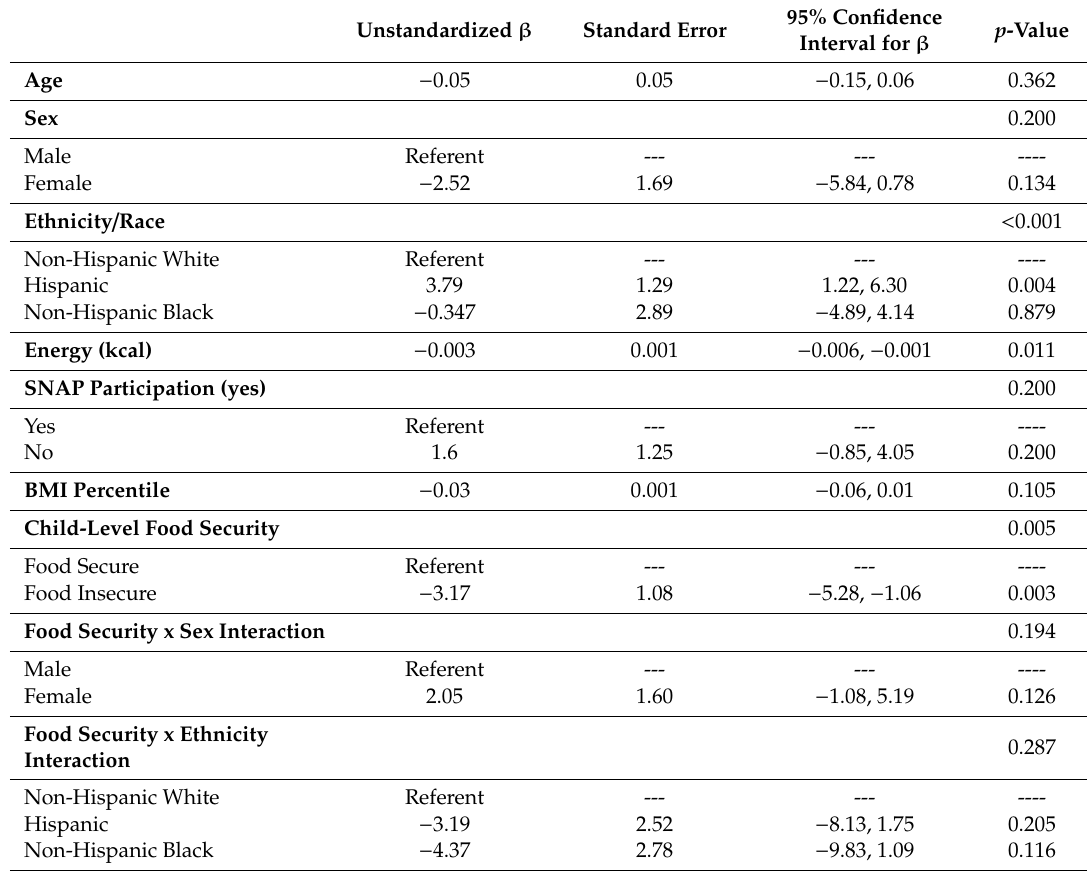
Table 2. Mixed e ff ects linear regression model of food security status and Healthy Eating Index-2015. Unstandardized β Standard